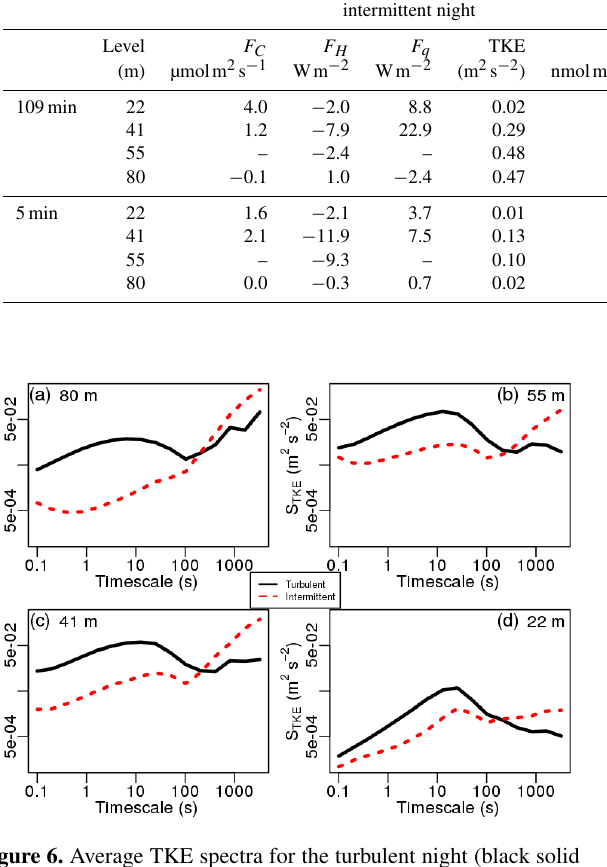
Figure 6. Average TKE spectra for the turbulent night (black solid lines) and the intermittent night (red dashed lines) for all levels, as indicated in each panel. In all panels, averages are calculated for each